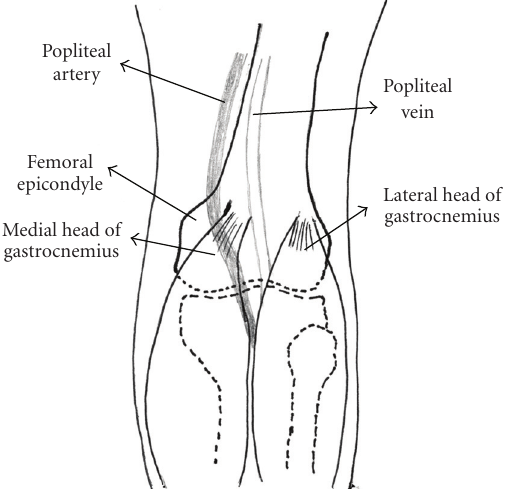
Figure 3: Type 2 PAES . The medial head of gastrocnemius muscle is attached more laterally. The popliteal artery courses medially and under the gastrocnemius muscle insertion.